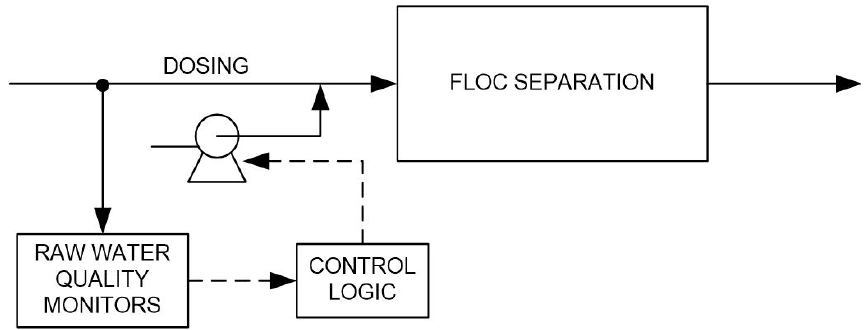
Figure 1. Sketch of a feed-forward control scheme based on raw water